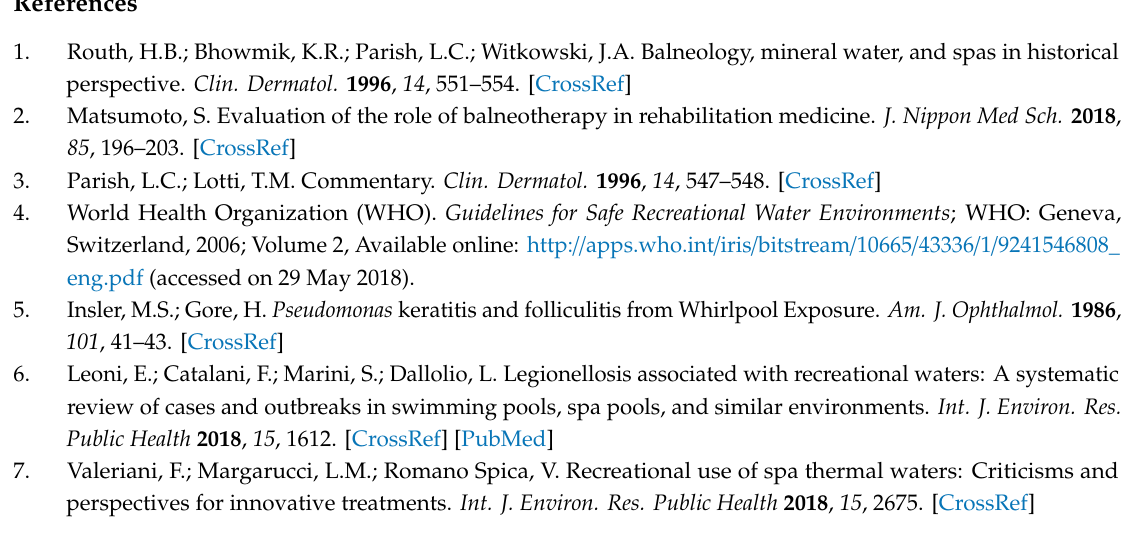
Figure S1: Map of Kaiafas thermal spring Anigrides Nymphes located in regional unit of Ileia of Western Greece Prefecture (Greece). The sampling points (Lake, Cave 1-3) are indicated by the yellow pins (left figure). The sampling points Cave 1-3 are indicated on the topography plan of Anigrides Nymphes [Spinos, J.; Agouridis, C.; Casati, L.; Dell Oro, B.; Bolanz, J.; Giannopoulos, V.; Deriaz, P. 1989] (right figure), Figure S2: Principal component analysis (PCA) 3D score plot based on bacterial families detected in thermal waters of Lake, Cave 1, Cave 2, Cave 3 of the Kaiafas thermal spring Anigrides Nymphes in Greece by metataxonomic analysis. The explained variances are shown in brackets. The total variance of the data set (100%) could be explained by the 3 first